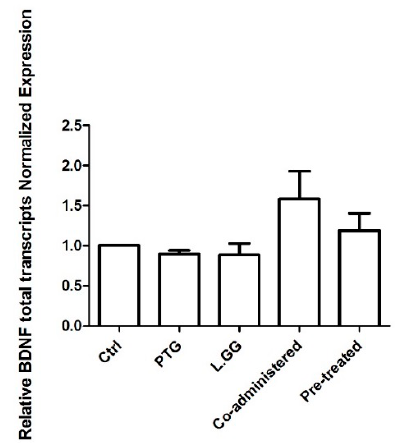
Figure 3. Quantitative PCR (qPCR) analysis of BDNF total transcripts in brain samples from control and treated rats, each group consisting of six rats. All data, represented as Fold Induction, are the results of at least three independent experiments (mean plus SEM). Data were analyzed by Kruskal–Wallis analysis of variance and Dunn’s Multiple Comparison Test.